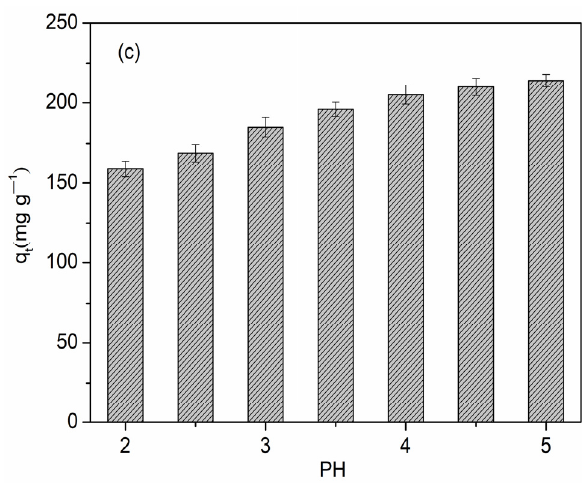
Figure 5. Effect of the initial pH value on Cu(II) adsorption on ( a ) FBPC 2.5-900-1% , ( b ) FBPC 2.5-900-2% , ( c ) FBPC 2.5-900-4% . Adsorbent dose = 0.35 g L − 1 ; shaking time = 120 min; temperature = 298 K; pH = 2–5; shaking speed = 300 rpm; initial Cu(II) concentration = 100 mg L − 1 .